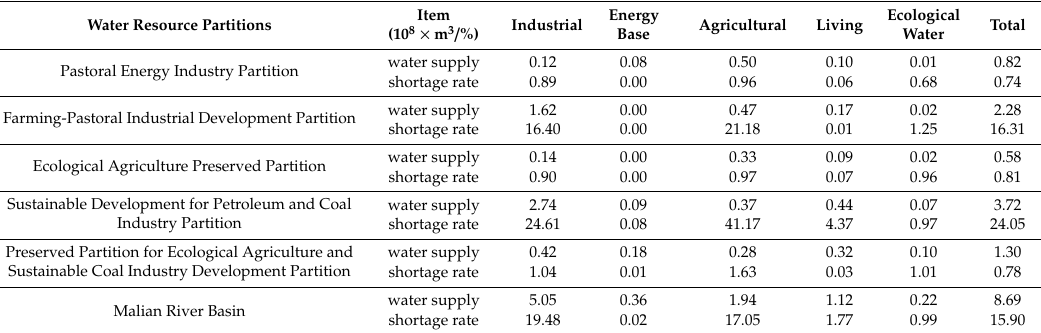
Table 8. Optimization model method result table in